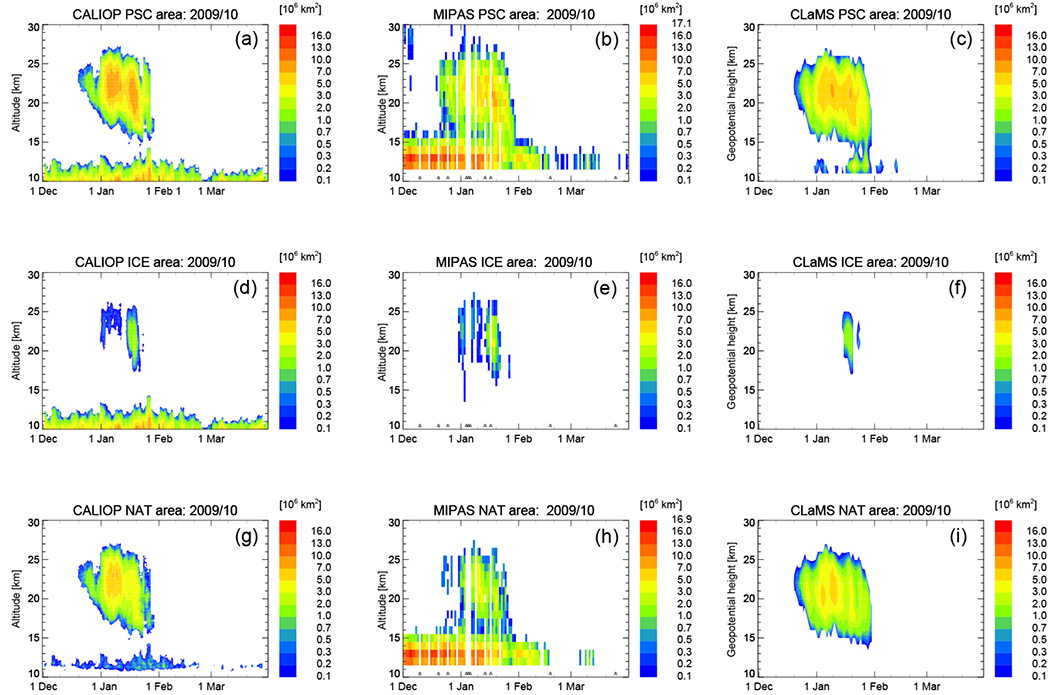
Comparison of PSC areal coverage between CALIOP (v2) (a, d, g), MIPAS (v1.2.8) (b, e, h), and CLaMS (c, f, i) from 1 December 2009 until 31 March 2010. Total PSC areal coverage (APSC) in 106 km2 (a, b, c) as well as further classified ice (d, e, f) and NAT PSCs (g, h, i) are presented as a function of time and altitude throughout the 2009/2010 NH winter. MIPAS observations and CLaMS simulations are restricted to latitudes < 82° N. PSC thresholds for CLaMS simulations are as follows: STS, 3.3 μm2 cm−3; NAT, 0.25 μm2 cm−3; ice, 0.5 μm2 cm−3. Black triangles in the time series of the measurements indicate data gaps. Please note that the color code is always identical except for the maximum value of the top color bin.